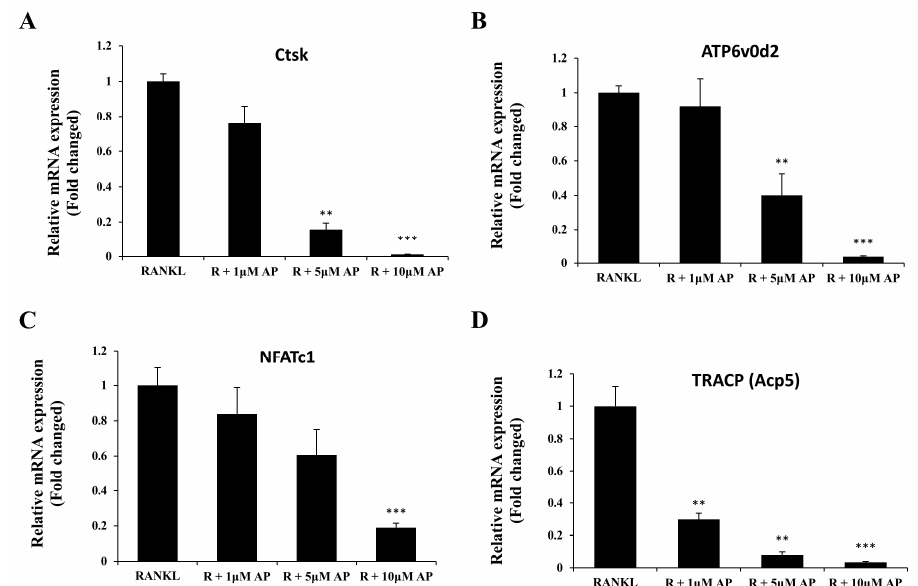
Figure 3. Andrographolide attenuates RANKL-induced gene expression. mRNA analysis of Ctsk